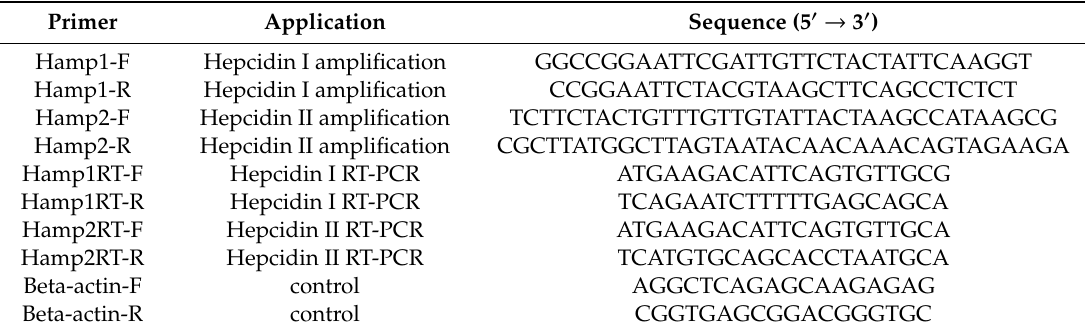
Table 1. Primers used in our